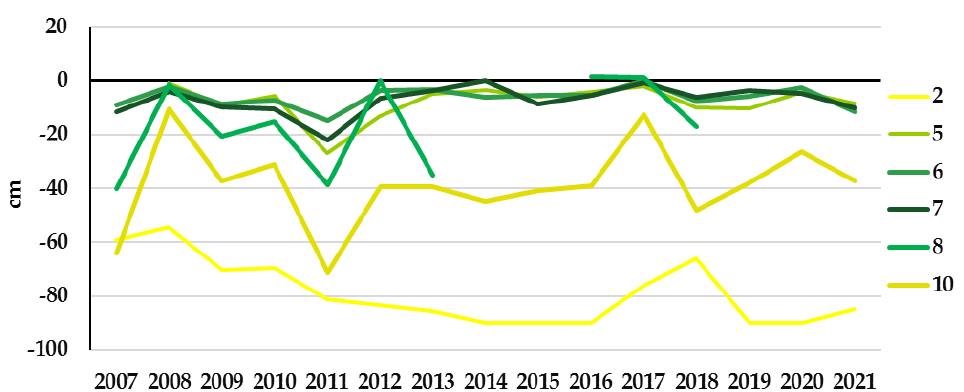
Figure 5. Average GWLs for the growing season (May − August) over the observation period on the monitoring plots not affected by rewetting.